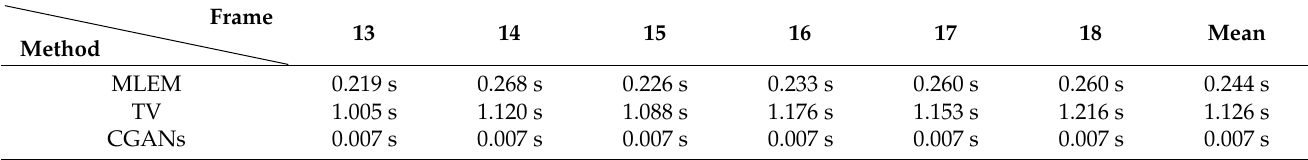
Table 4. Reconstruction times for Zubal brain.